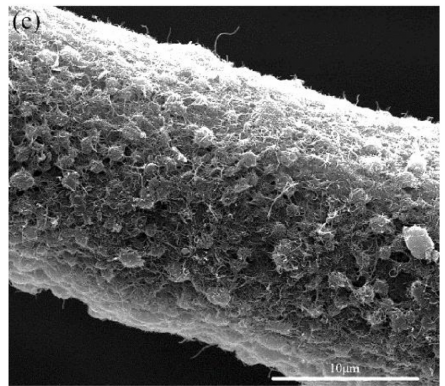
Figure 7. Poly-p-phenylene-benzimidazole-terephthalamide (PBIA) fiber with CNTs attached to the surface [98]. Reprinted with permission from ref. [98]. Copyright 2020